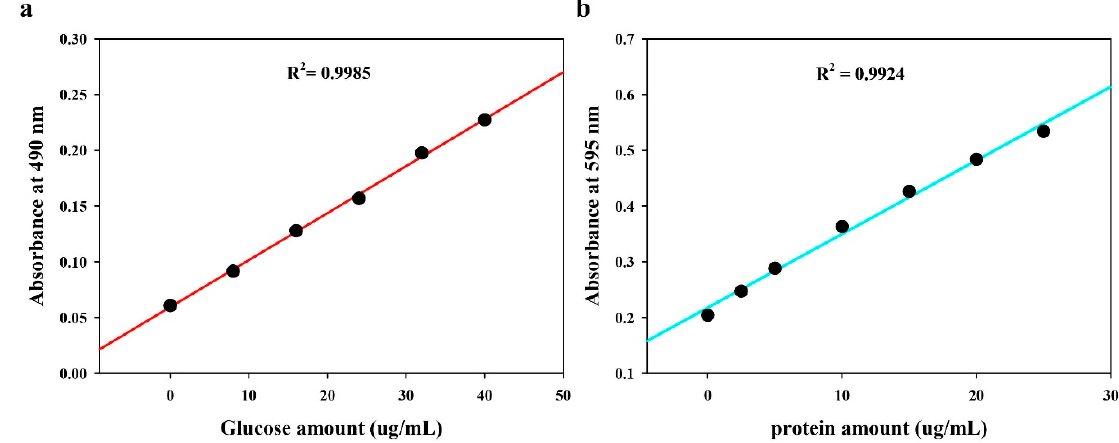
Figure 2. Standard curves for quantification analysis of polysaccharide ( a ) and ( b ) protein.